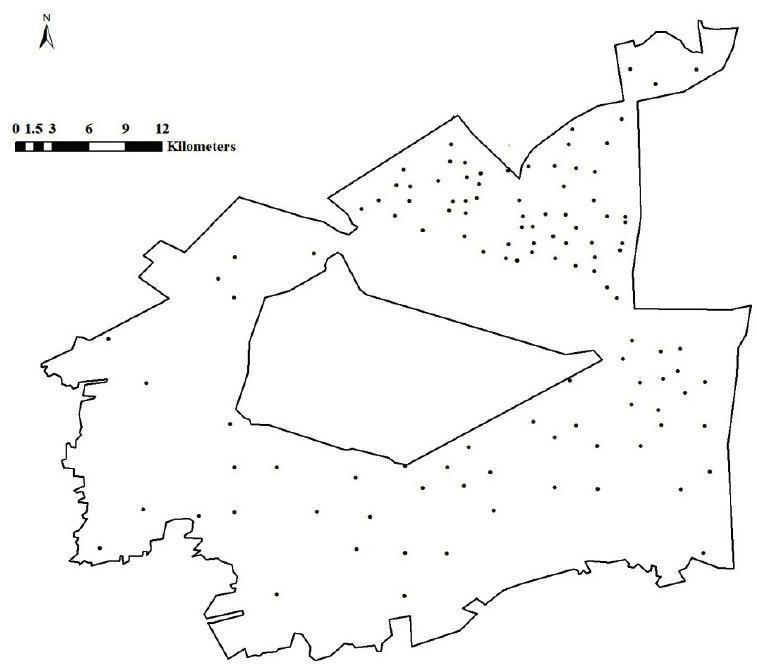
Figure 2. Soil sampling bitmaps. Note: the blank area is the North Dagang